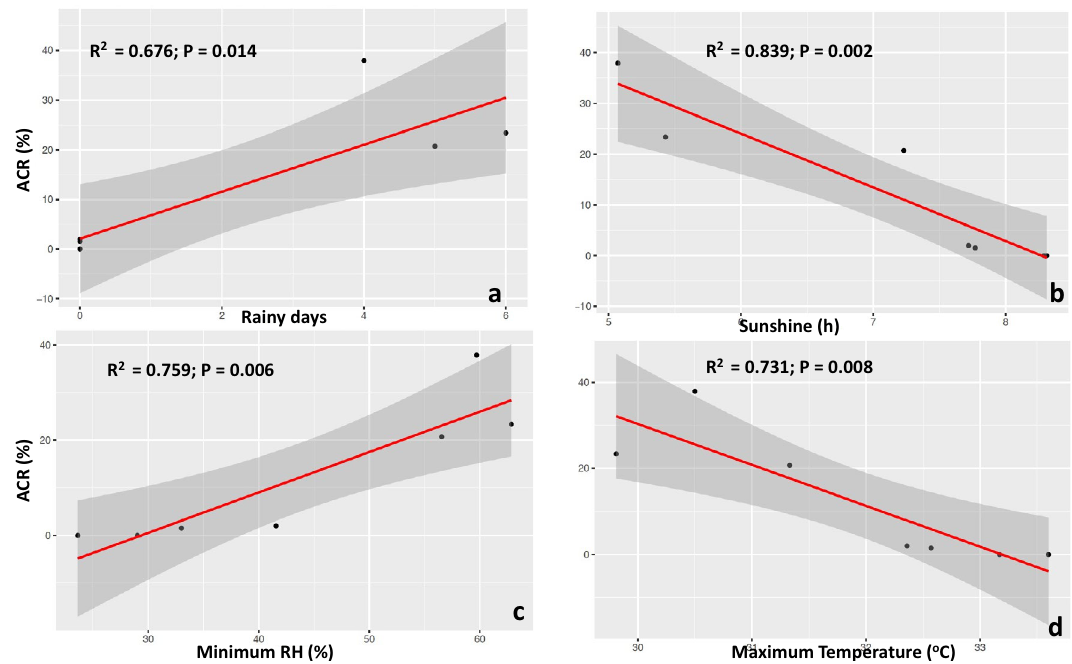
Figure 1. Weather parameters bearing influence on D. alata crossability rate (ACR) at IITA, Nigeria: (a) number of rainy days, (b) sunshine, (c) minimum relative humidity (RH), (d) maximum temperature.